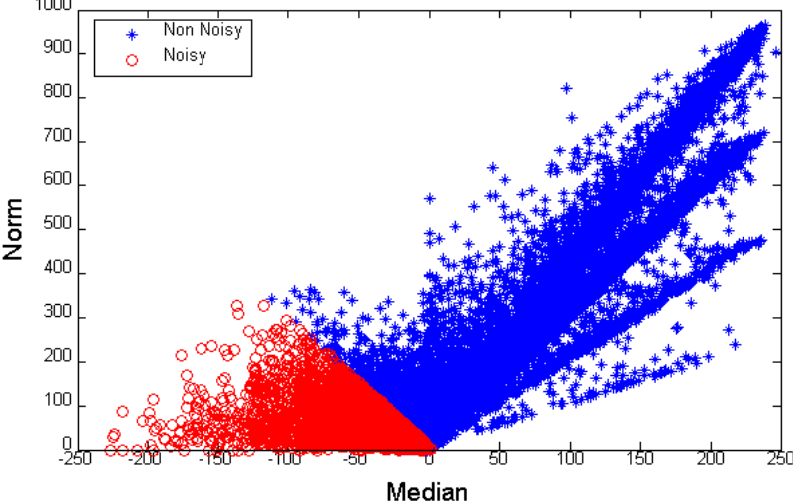
Figure 1. Classification of noisy pixels with Median and Norm Features.